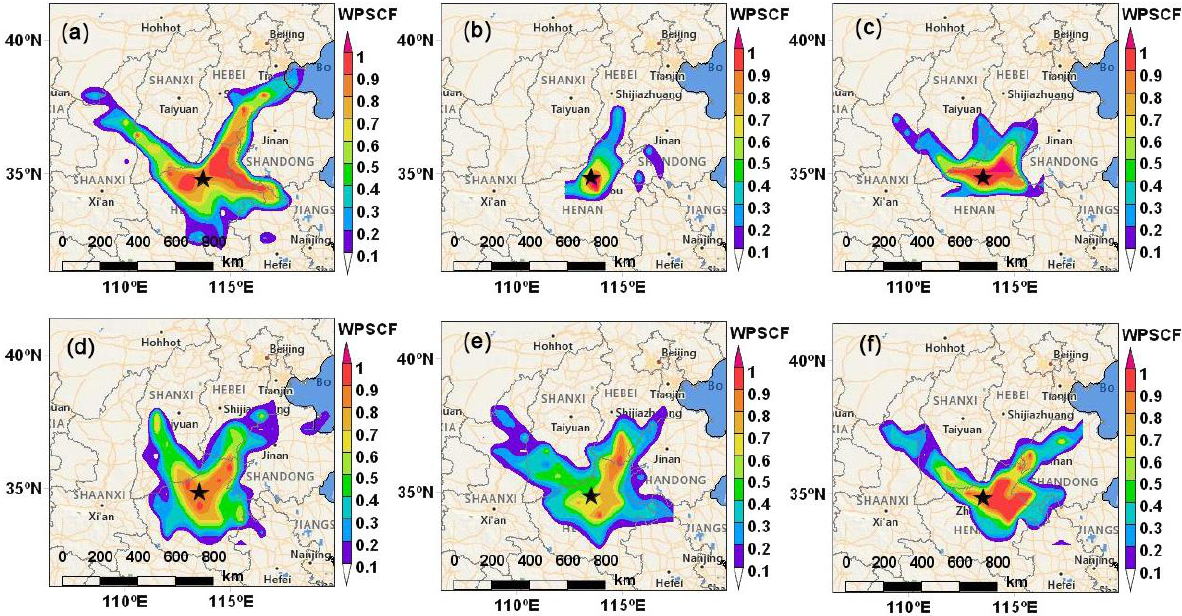
Figure 9. Maps of weighted potential source contribution function (WPSCF) for PM 2.5 arriving in Henan during the six heavy PM 2.5 pollution episodes (HPEs). ( a ) HPE1, ( b )HPE2, ( c ) HPE3, ( d ) HPE4, ( e ) HPE5, and ( f ) HPE6.